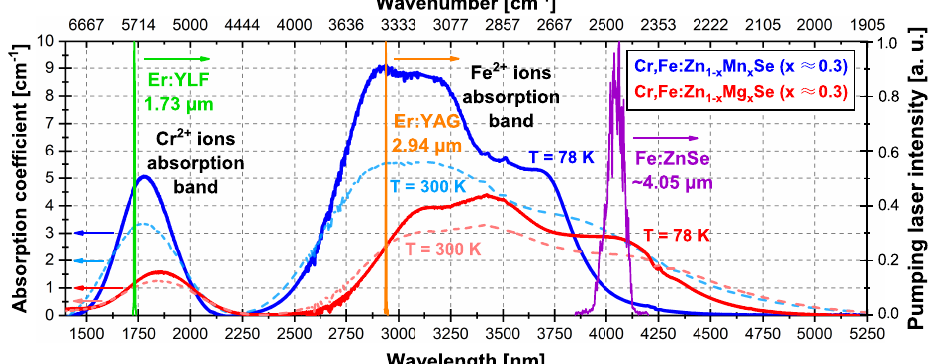
Figure 2. Absorption spectra of Cr,Fe:Zn 1 − x Mn x Se (x ≈ 0.3) (dark and light blue curves) and Cr,Fe:Zn 1 − x Mg x Se (x ≈ 0.3) samples (red and pink curves) at 78K (full lines) and at 300K (dashed lines). The green, orange, and purple curves show the pumping laser’s oscillation spectra at wave- lengths of 1.73, 2.94, and ∼ 4.05 µ m,